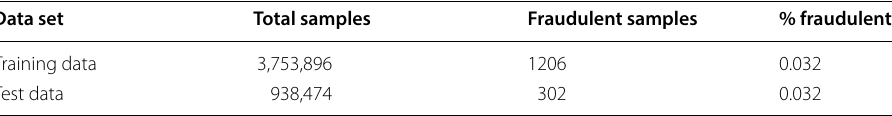
Table 5 Training and test set